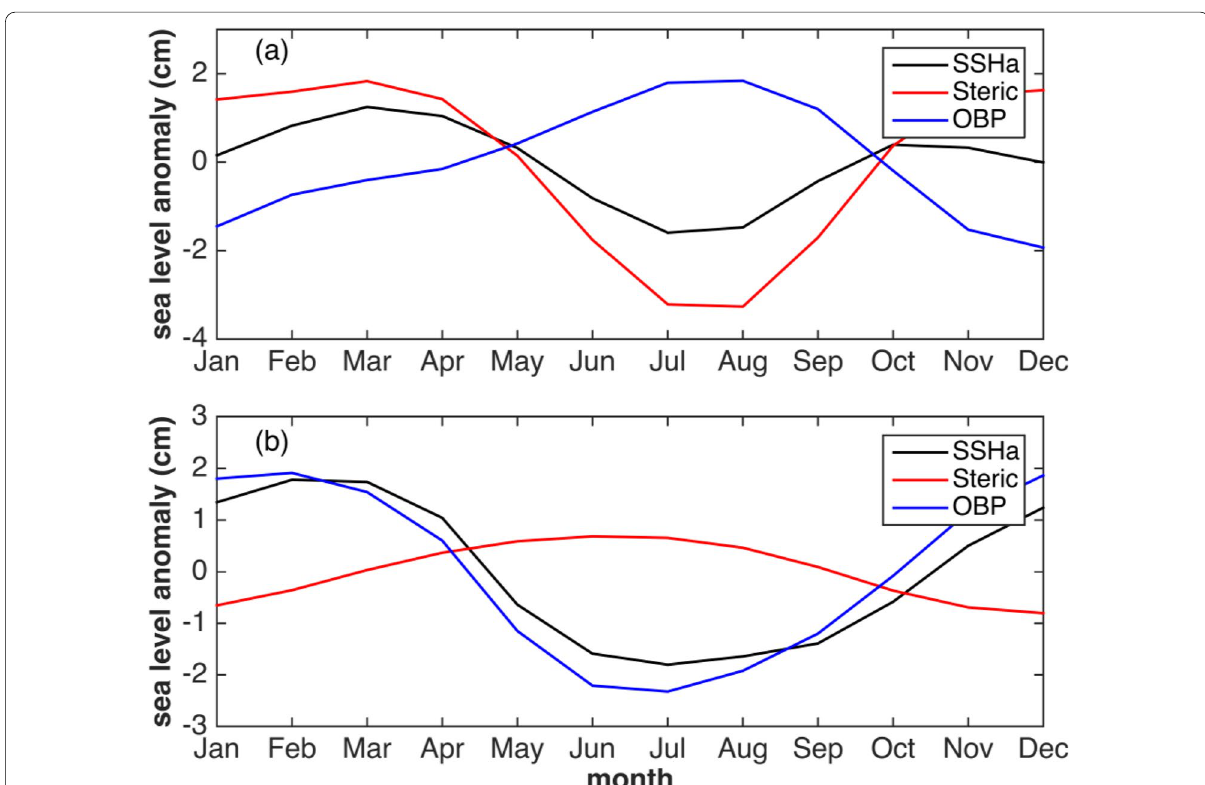
Fig. 5 a Annual cycle of sea level, steric sea level and ocean bottom pressure anomalies from PCOM Exp. 1 averaged in the tropical western Pacific (160°